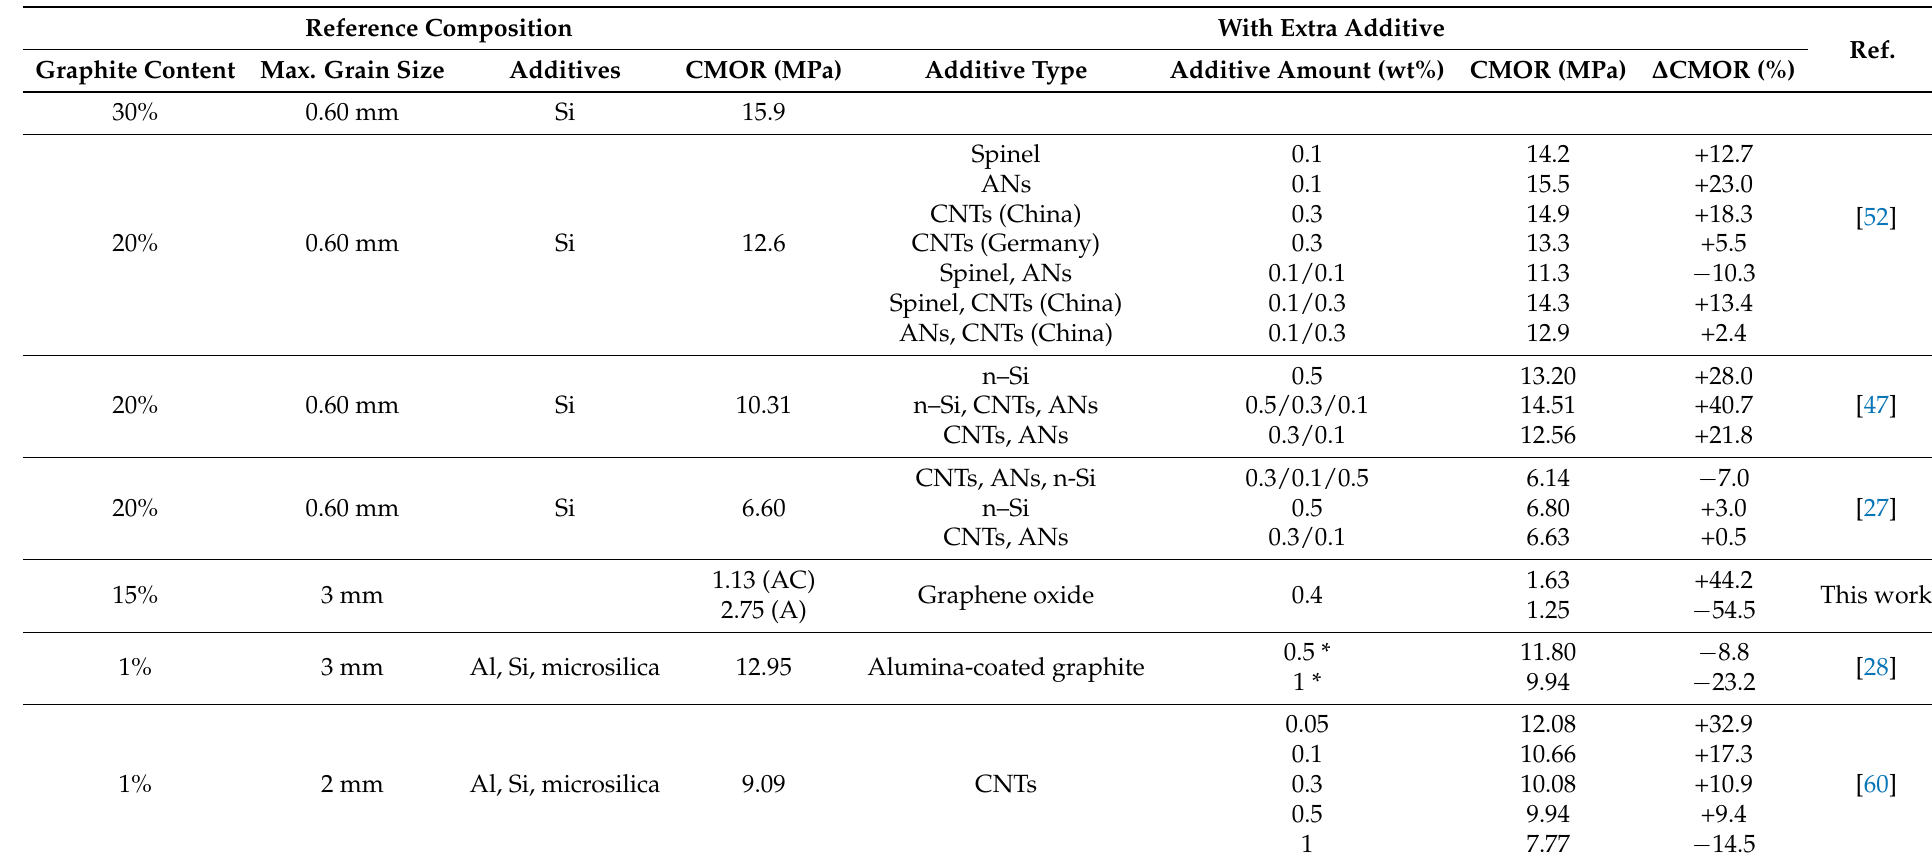
Table 4. Comparison of literature works on reinforcement of carbon-bonded alumina with the present study. Coking temperature = 1000 °C; CNTs =